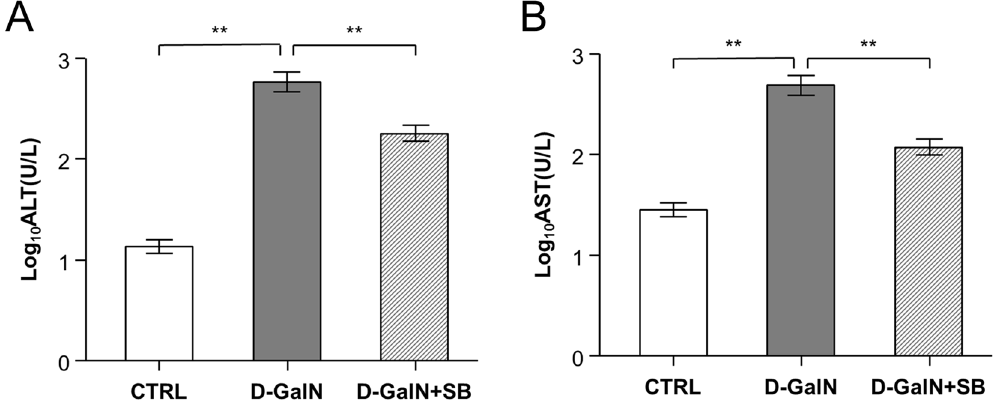
Figure 1. Effects of D-GalN treatment and S. boulardii supplementation on ALT ( A ) and AST ( B ) activities. Values are displayed as means ± SEMs. * P-value < 0.05 according to Student’s